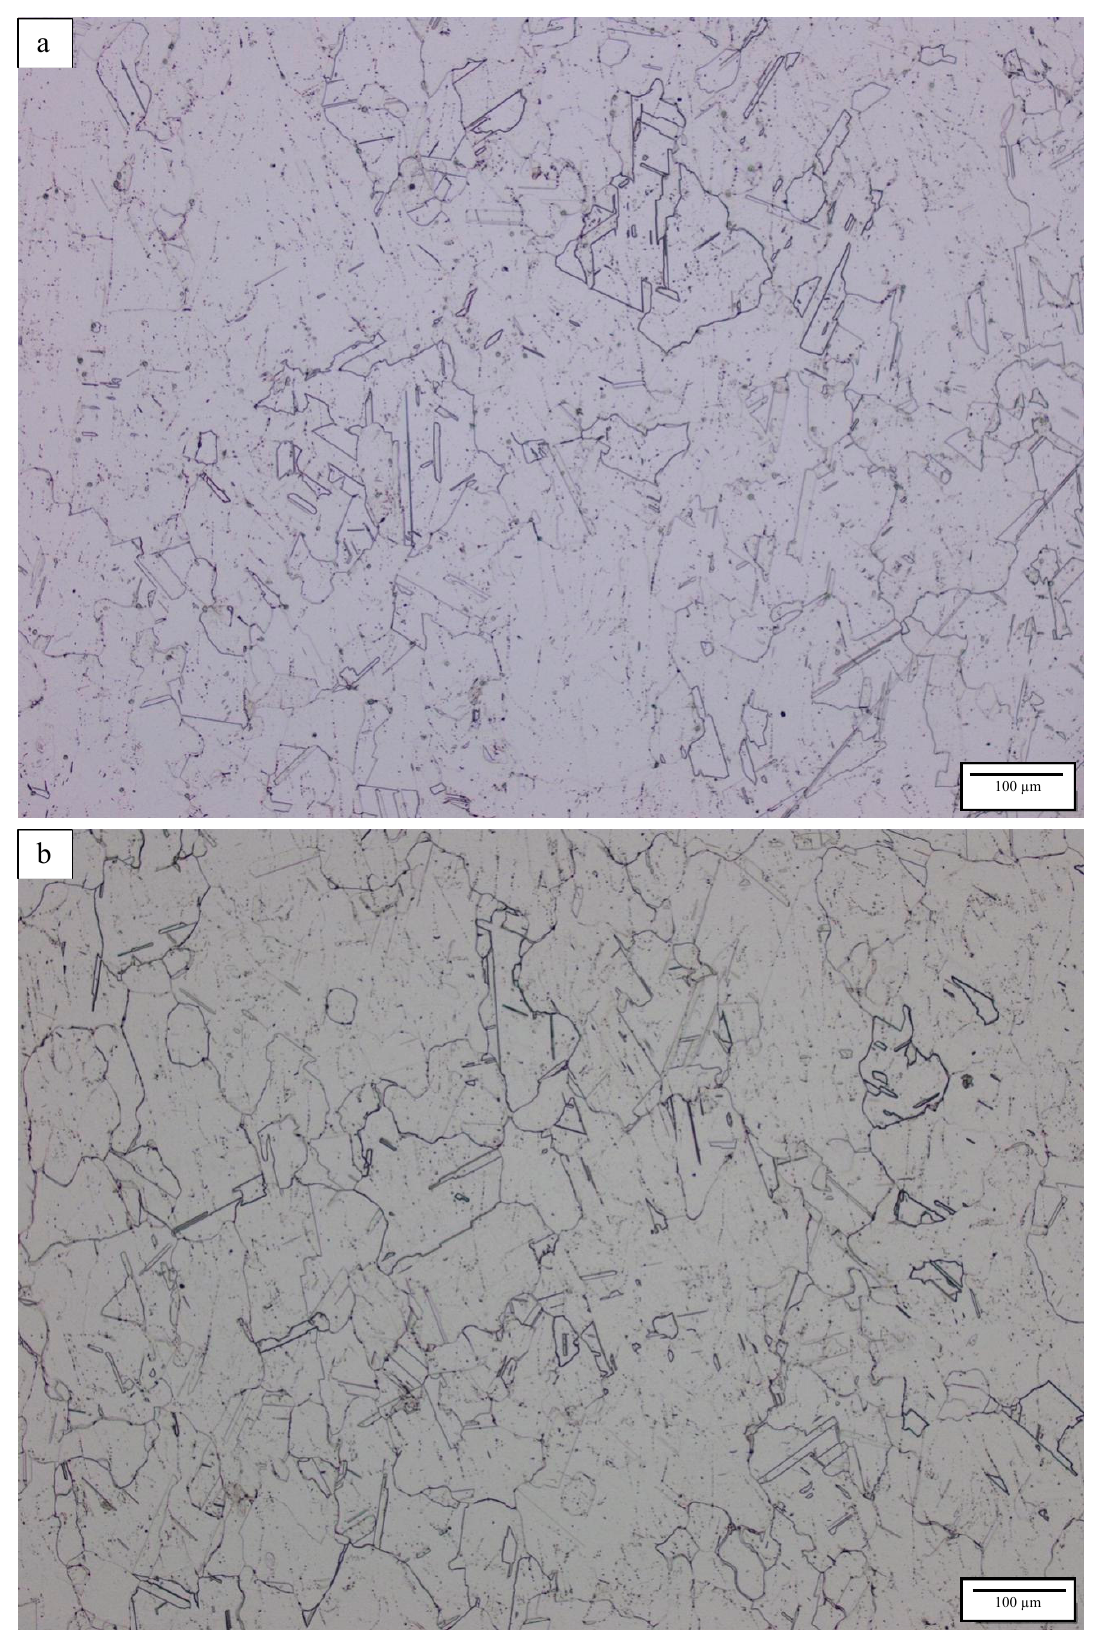
Figure 5. OM images for Variant 6 ( a ) and Variant 7 ( b ) (Table 1).